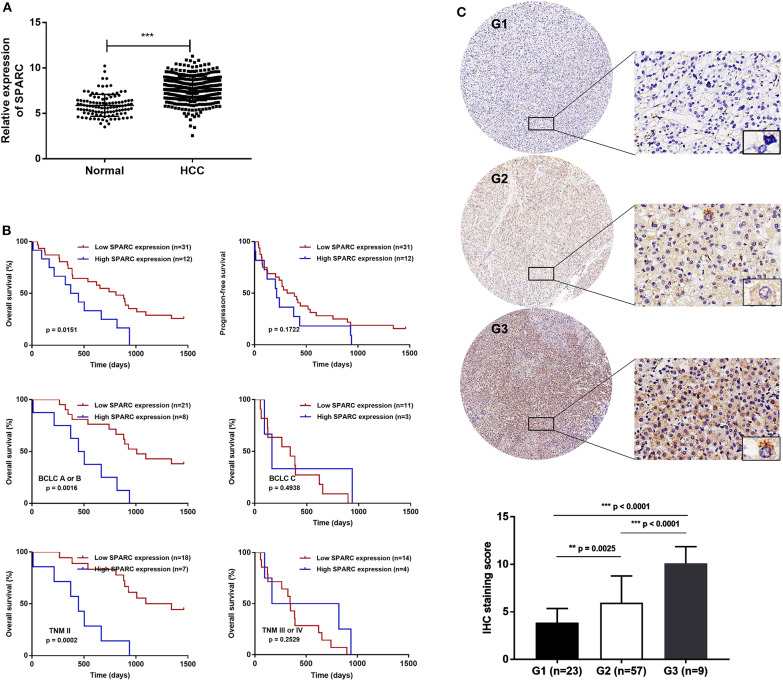
Expression of SPARC and its clinical significance in HCC patients. (A) Compared with healthy individuals, SPARC was highly expressed in the serum of patients with HCC in the TCGA dataset (p < 0.001). (B) There was an association between the serum expression of SPARC in patients with HCC receiving TACE and OS time. A cut-off value was implemented for dividing patients into a group with high expression (n = 12, serum SPARC ≥ 244 ng/mL) and a group with low expression (n = 31, serum SPARC <244 ng/mL). Kaplan-Meier analysis revealed that the OS of patients with high expression of SPARC might be poor (p = 0.0151). Both groups exhibited the same PFS (p = 0.1722). Regarding the cut-off value, as well as BCLC staging, we divided patients into the BCLC A/B low (n = 21) and high expression (n = 8) groups, and the BCLC C low (n = 11), and high expression (n = 3) groups, respectively. The OS of patients in both the BCLC A/B low and high expression groups with lower expression of SPARC appeared to be better (p = 0.0016). The cut-off value together with TNM grading were taken into consideration for dividing patients with TNM II high (n = 7) and low expression (n = 18) groups, and the TNM III/IV high (n = 4), and low expression (n = 14) groups, respectively. A higher serum level of expression of SPARC represented a shorter OS in the TNM II groups (p = 0.0002). (C) Cytoplasmic immunoreactivity (brown) and nuclear (blue) was observed. SPARC was significantly upregulated in higher grade human pathological HCC tissues. Immunohistochemical analysis (20 ×, and 400 × magnification) revealed an increased expression of SPARC in poorly- (G3, p < 0.0001; n = 9) compared with well-(G1, p < 0.0001; n = 23) and moderately- (G2, p = 0.0025; n = 57) differentiated HCC tissues. HCC, hepatocellular carcinoma; NOR, healthy individuals; TACE, transarterial chemoembolization; OS, overall survival; PFS, progression-free survival; BCLC, Barcelona Clinic Liver Cancer; TNM, Tumor Node Metastasis.